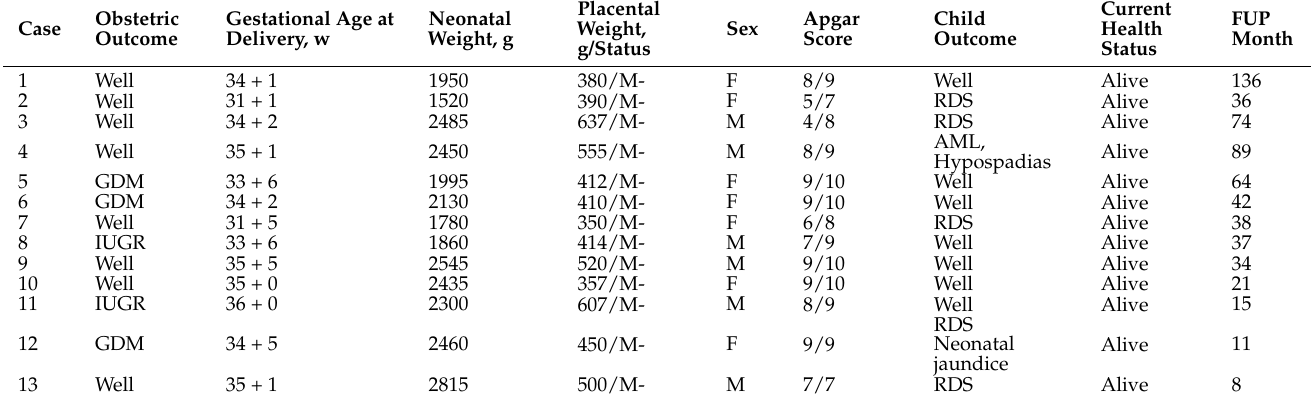
Table 3. Obstetric and pediatric outcomes of the study